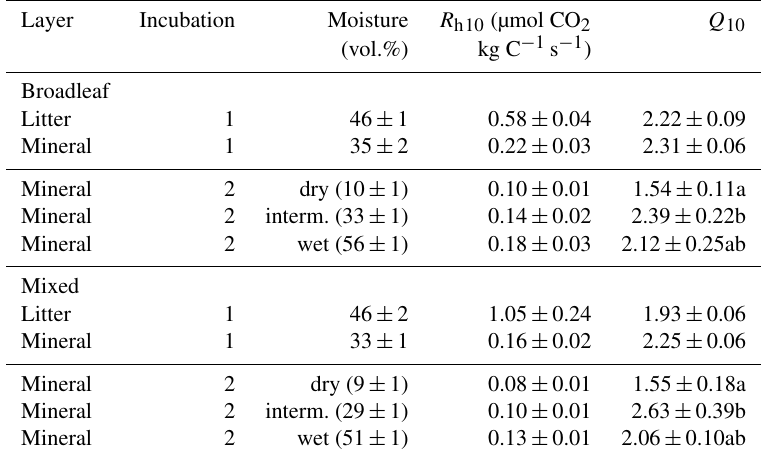
Figure 2. (a) Relationship between soil CO 2 efflux ( R s ) and soil temperature, and (b) R s and soil moisture (vol.%) at a broadleaf and a mixed forest in the Bhutan Himalayas. (c) Relationship between heterotrophic soil respiration ( R h ) and soil temperature and (d) R h and soil moisture (vol.%) as determined during a laboratory incubation. A temperature response was fitted with an exponential function (Eq. 1) and a moisture response was fitted with a polynomial function (Eq. 3). Error bars represent standard error of the mean (SE). Basal respiration rates at 10 ◦ C ( R s10 , R h10 ) and temperature sensitivity of R h ( Q 10 ) are given (mean ± SE). Table 2. Basal respiration rates ( R h10 ) and temperature sensitivity ( Q 10 ) of litter and mineral soil (0–10cm depth) samples derived from laboratory incubations. Incubations took place initially after sampling (Incubation 1) using a set of three samples per plot (six plots per site). Subsequently, sets were split and the moisture sensitivity of R h was tested (Fig. 2d). Subsequent to moisture incubations, the different subsets (dry, intermediate, wet) were re-incubated to test temperature sensitivities at different moisture contents (Incubation 2). The time lag between Incubation 1 and Incubation 2 was approximately 10 weeks. Different letters indicate significant differences in Q 10 between soil moisture levels of the mineral soil